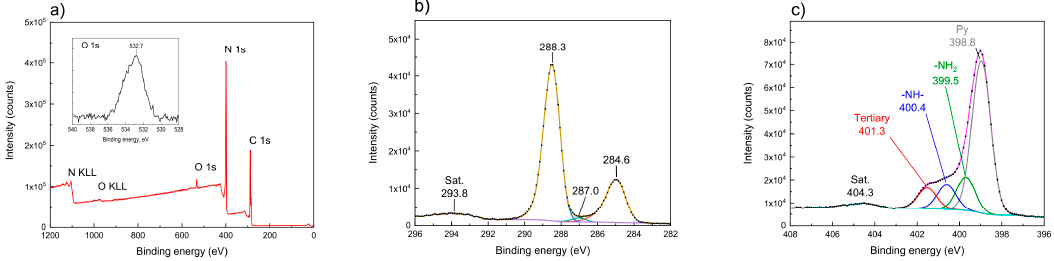
Figure 7. XPS survey spectrum of carbon nitride obtained from melamine (M-10/600/4) and O 1 s spectrum (insert) ( a ); C 1 s spectrum ( b ) and N 1 s ( c ).